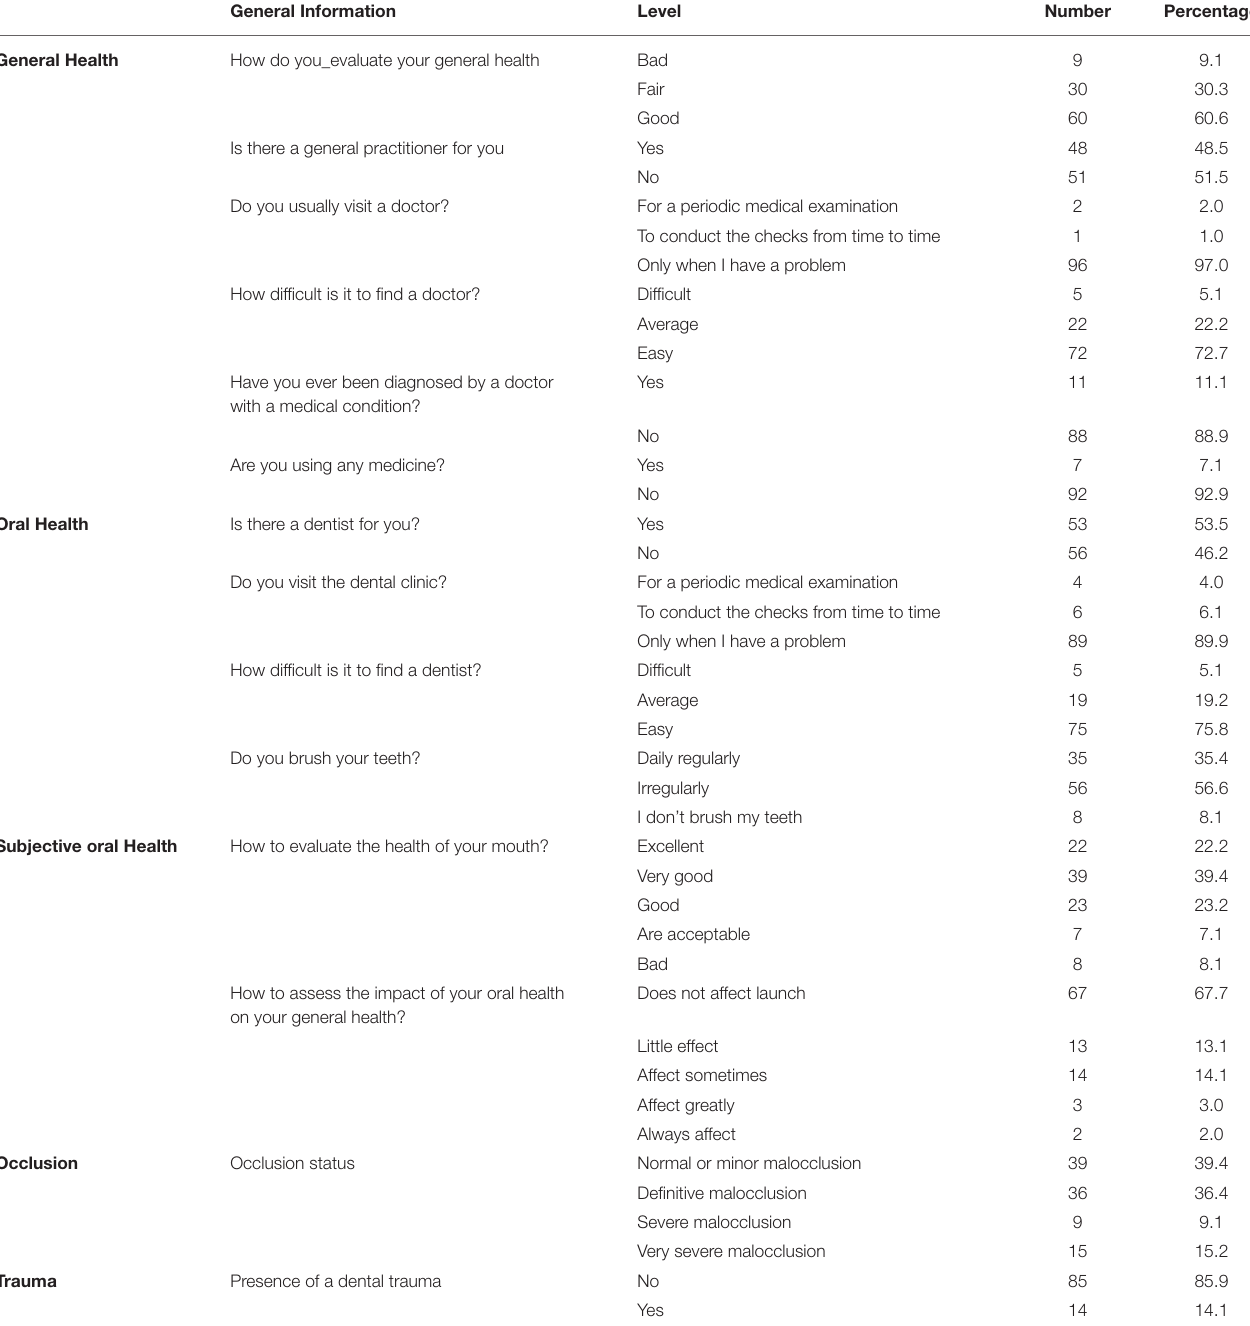
TABLE 1 | Overall scores of study population. General Information Level Percentage General